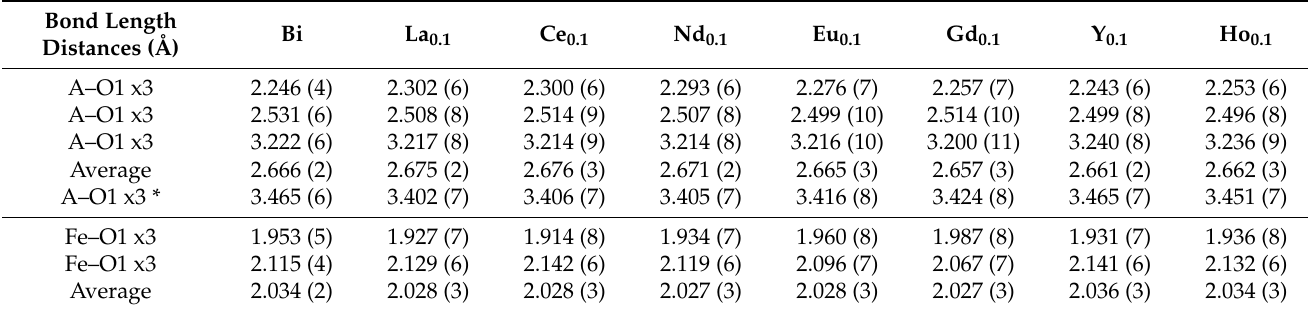
Table 3. Selected cation–oxygen distances for BiFeO 3 and substituted Bi 0.9 RE 0.1 FeO 3 (A-cation is Bi or Bi 0.9 RE 0.1 ) forming the main coordination around two types of cations in the perovskite